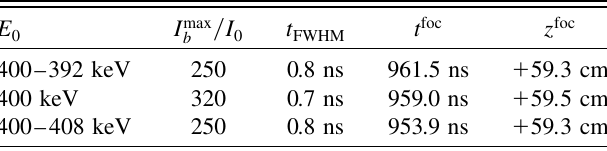
TABLE V. Compression dependence on initial linear increase (cid:2) t (cid:3) by (cid:13) 2% with T or decrease in E 0 (cid:4) 300 ns , and f (cid:4) 0 : 5 using the smooth waveform 400 keV , t p across the 3 cm long